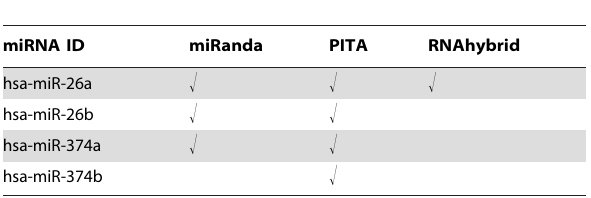
Table 2. Analysis output with miRecords, that integrates prediction